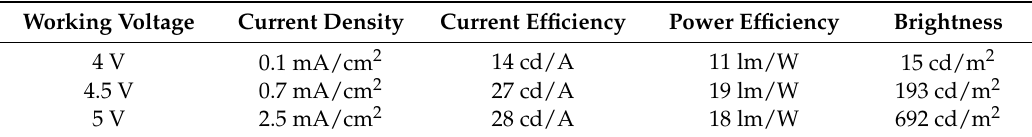
Table 2. Test results of test